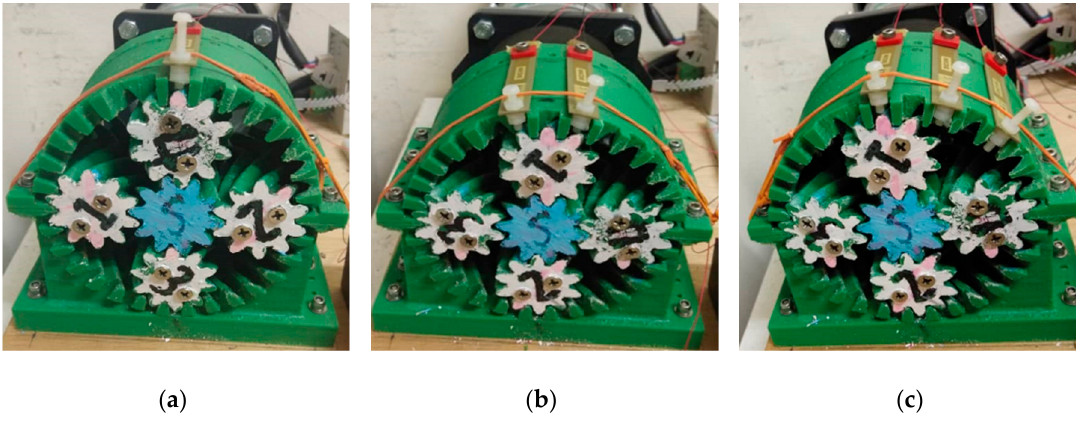
Figure 9. 45 ° view for PZT increasing number : ( a ) one PZT, ( b ) two PZTs and ( c ) three PZTs.